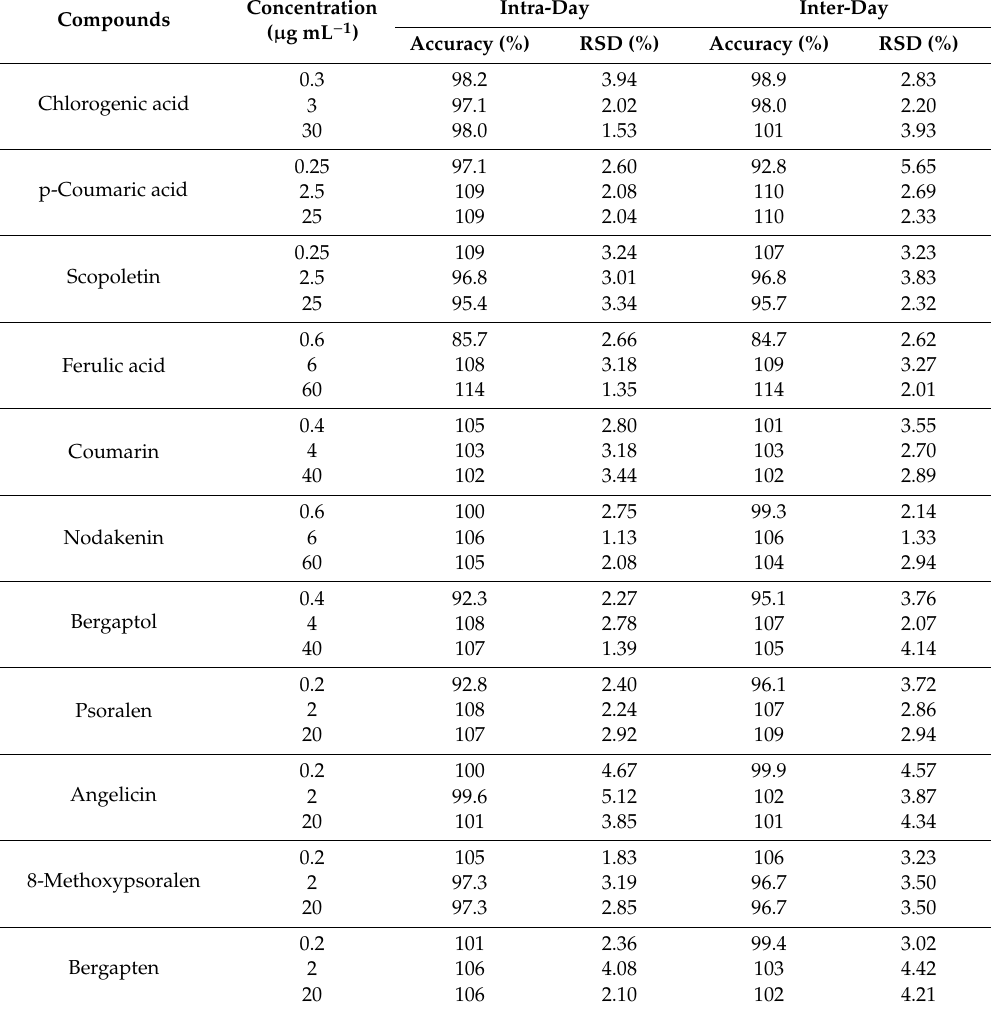
Table 2. Intra-day and inter-day precision of the 19 compounds using the SSMD method ( n = 6).